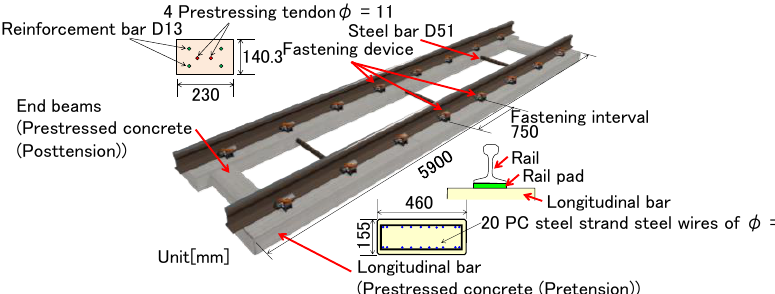
Figure 1. Outline of the ladder sleeper.